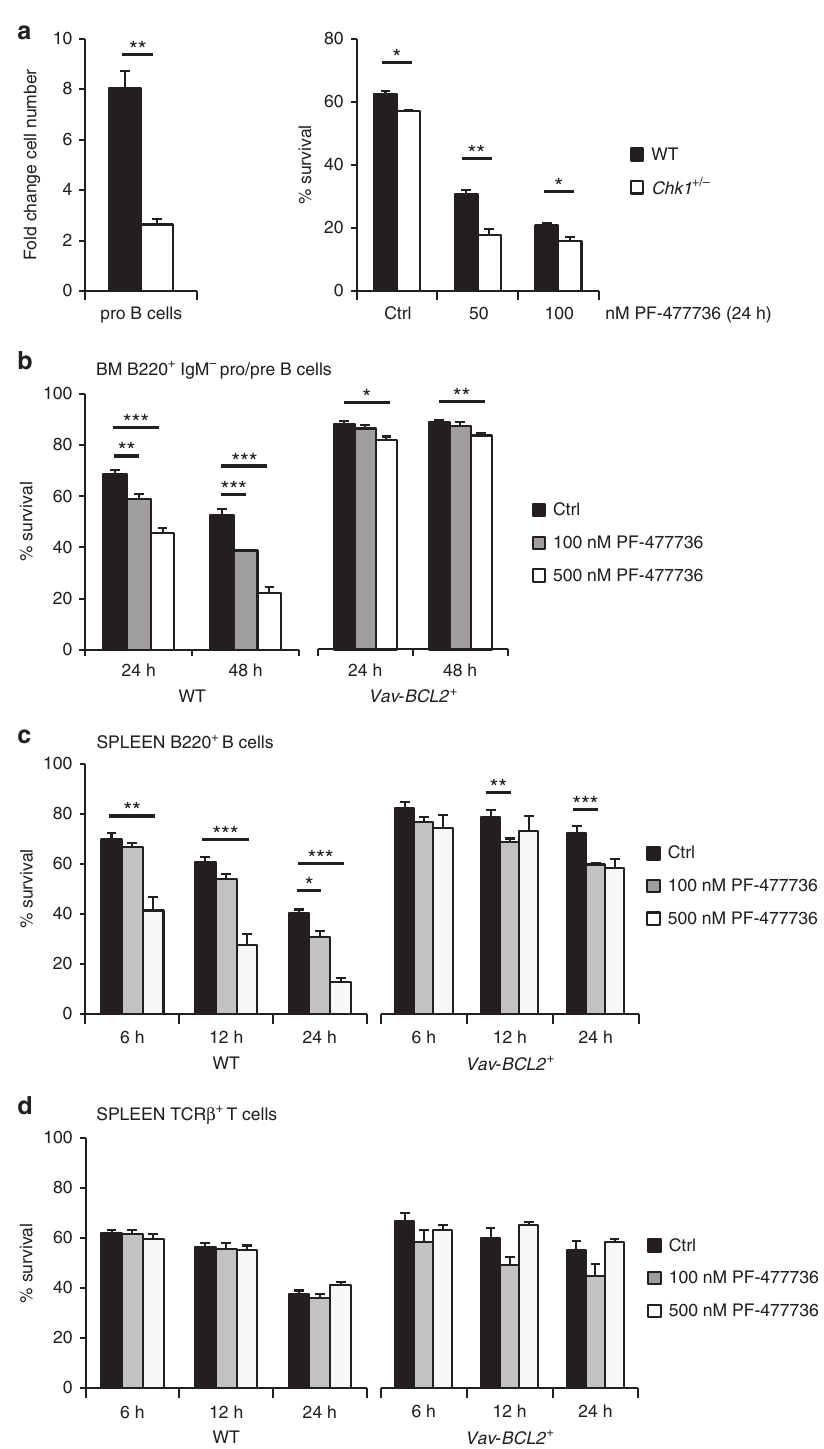
Fig. 3 Overexpression of anti-apoptotic BCL2 blocks cell death by CHK1i in vitro a Pro B cells (NK1.1 − B220 + CD19 + AA4.1 + μ HC − CD25 − ckit + ) were isolated from wild-type and Chk1 + / − C57Bl/6N mice and expanded for four days in IL-7 containing medium ( n = 3/genotype). At day 4 cells were counted to assess cell expansion (left) and treated for additional 24 h with graded doses of the CHK1 inhibitor PF-477736 (right). Survival was assessed using AnnexinV-staining and fl ow cytometry. b FACS-sorted wild-type (WT) and BCL2 transgenic ( Vav-BCL2 + ) bone marrow derived B220 + IgM − pro/pre B cells were treated for 24 h and 48 h with PF-477736 or solvent control (DMSO). Cells were processed for survival analysis using a fl ow cytometer and AnnexinV/7AAD staining. c , d Total splenocytes were cultured for the indicated time in the presence of PF-477736 or solvent control (DMSO) and processed for survival analysis using B220/TCR β /AnnexinV-staining and fl ow cytometry. c Quanti fi cation of B220 + AnnexinV − cells. d Quanti fi cation of TCR β + AnnexinV − cells. Bars in b – d represent means of n = 3 animals/genotype ± S.E.M. * p < 0.05, ** p < 0.01, *** p < 0.001 using unpaired Student ´ s t